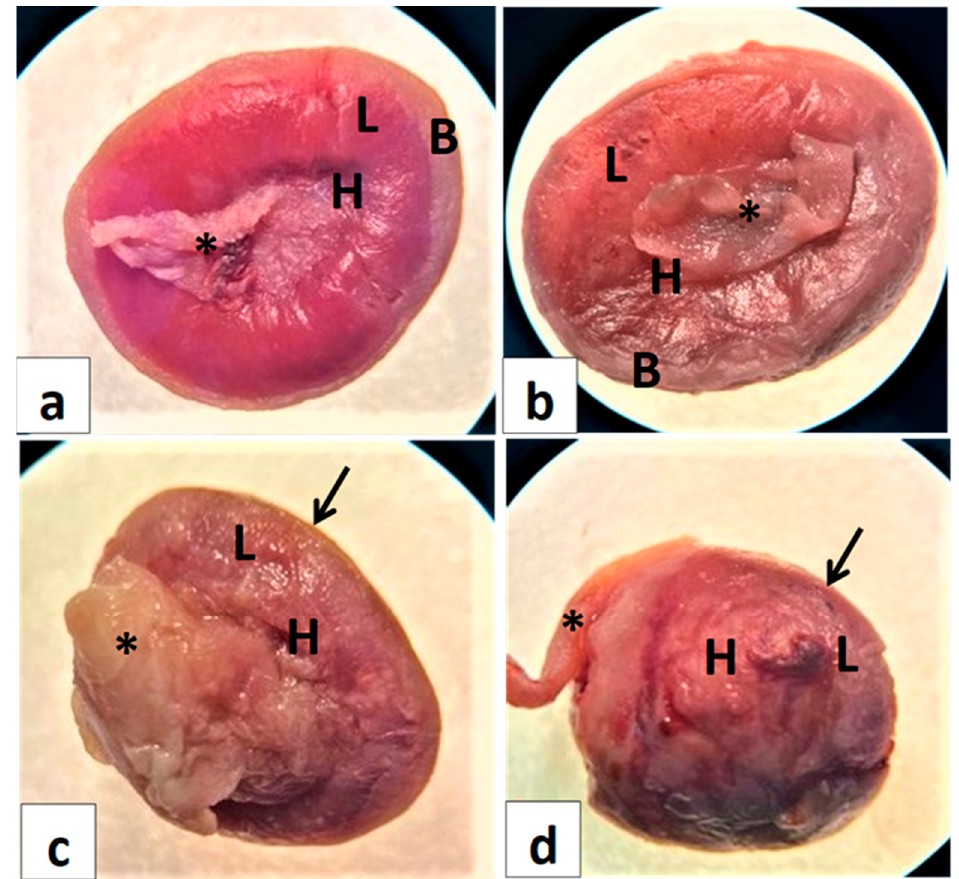
Figure 4. Photomacrographs of the frontal view of placental morphologies in control and pregnant rats treated with metronidazole at different gestation periods. ( a ) Normal control, red-colored labyrinth (L), thick basal decidua (B). ( b ) Group I indicate discoloration of the labyrinth (L) and adherence of the umbilical cord (*) to the chorionic surface (H). ( c ) Group II indicates placental hypotrophy, and thin basal decidua (arrow). ( d ) Group III indicates reduced placenta and placental hypotrophy, necrosis, and the disappearance of basal decidua (arrow).